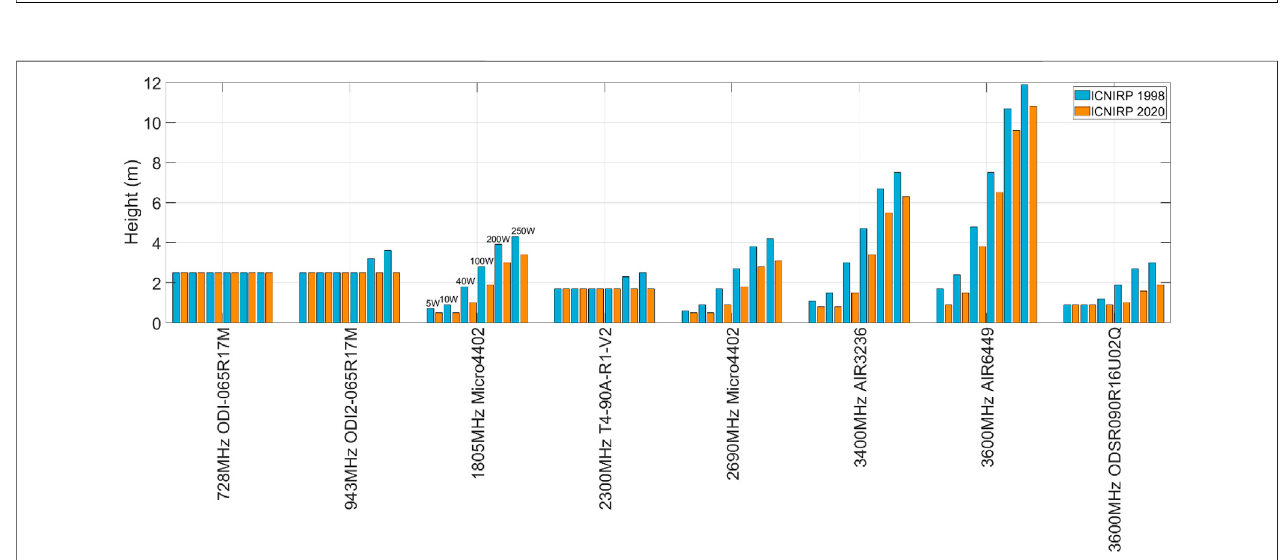
FIGURE 5 | Heights of the compliance boundary box for the selected BS antennas (for frequencies below 6 GHz) obtained by applying ICNIRP 1998 and ICNIRP 2020 general public reference levels for input powers of 5, 10, 40, 100, 200, and 250 W.